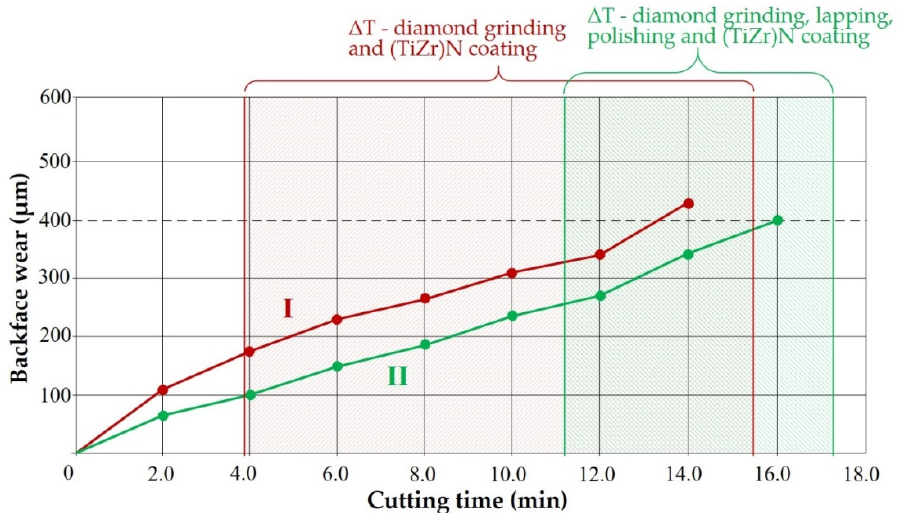
Figure 12. Average curves of wear development over time along the back surface and the range of changes in resistance ( ∆ T) of cutting edges of Al 2 O 3 +TiC ceramic inserts with (TiZr)N coatings formed on substrates after diamond grinding (I) and diamond grinding, lapping and polishing (II) when milling hardened steel 100CrMn6 (V = 380 m/min, S = 0.15 mm/tooth, t = 1